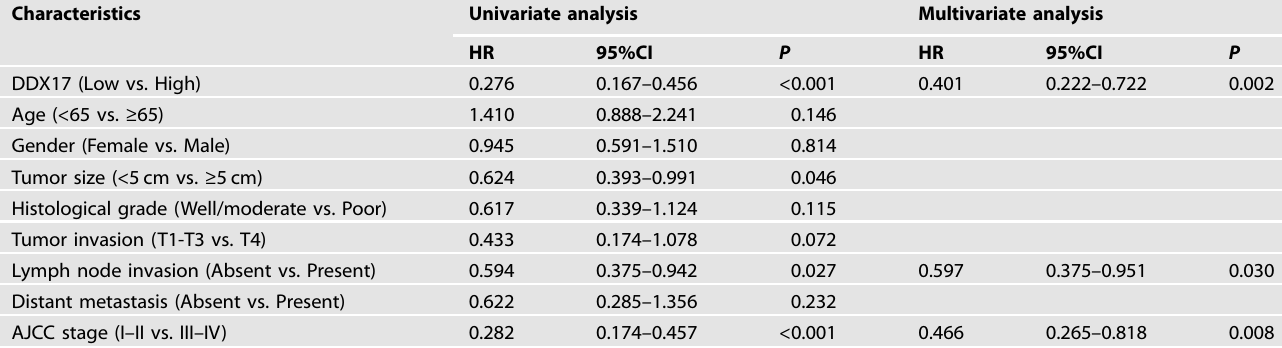
Table 2. Univariate and multivariate analysis of factors associated with survival in CRC. Characteristics